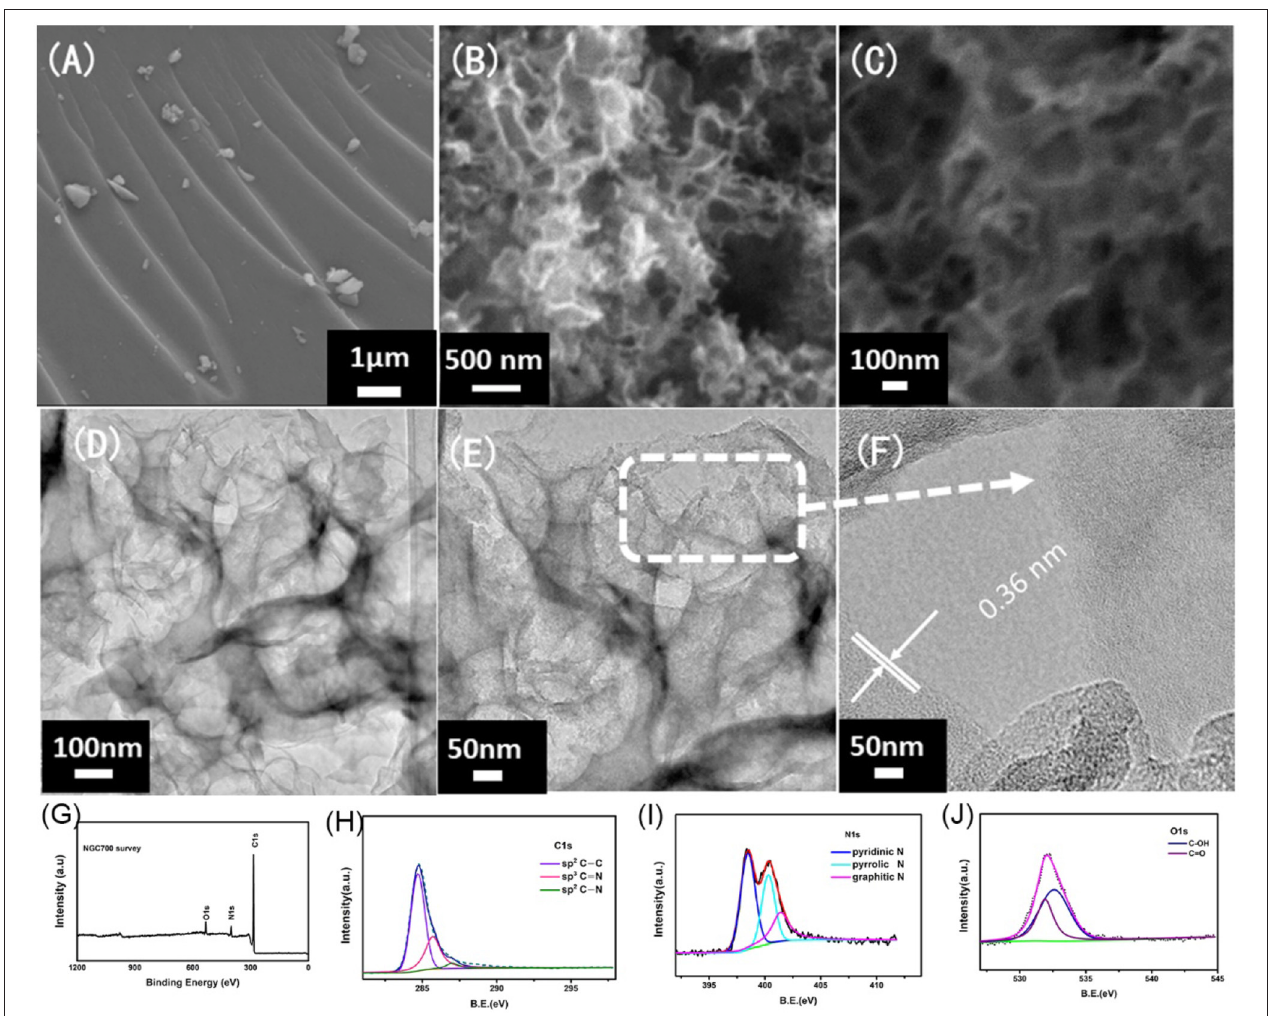
FIGURE 5 | SEM images of the (A) G700, (B,C) NGC700 at different magnification. (D–F) TEM images of the NGC700 at different magnification. XPS spectrum of NGC700: (G) Survey spectra, (H) C1s XPS, (I) N1s XPS, and (J) O1s